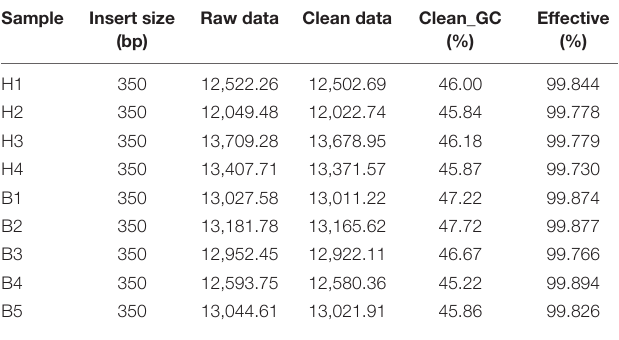
TABLE 2 | The statistical table of sequencing data.